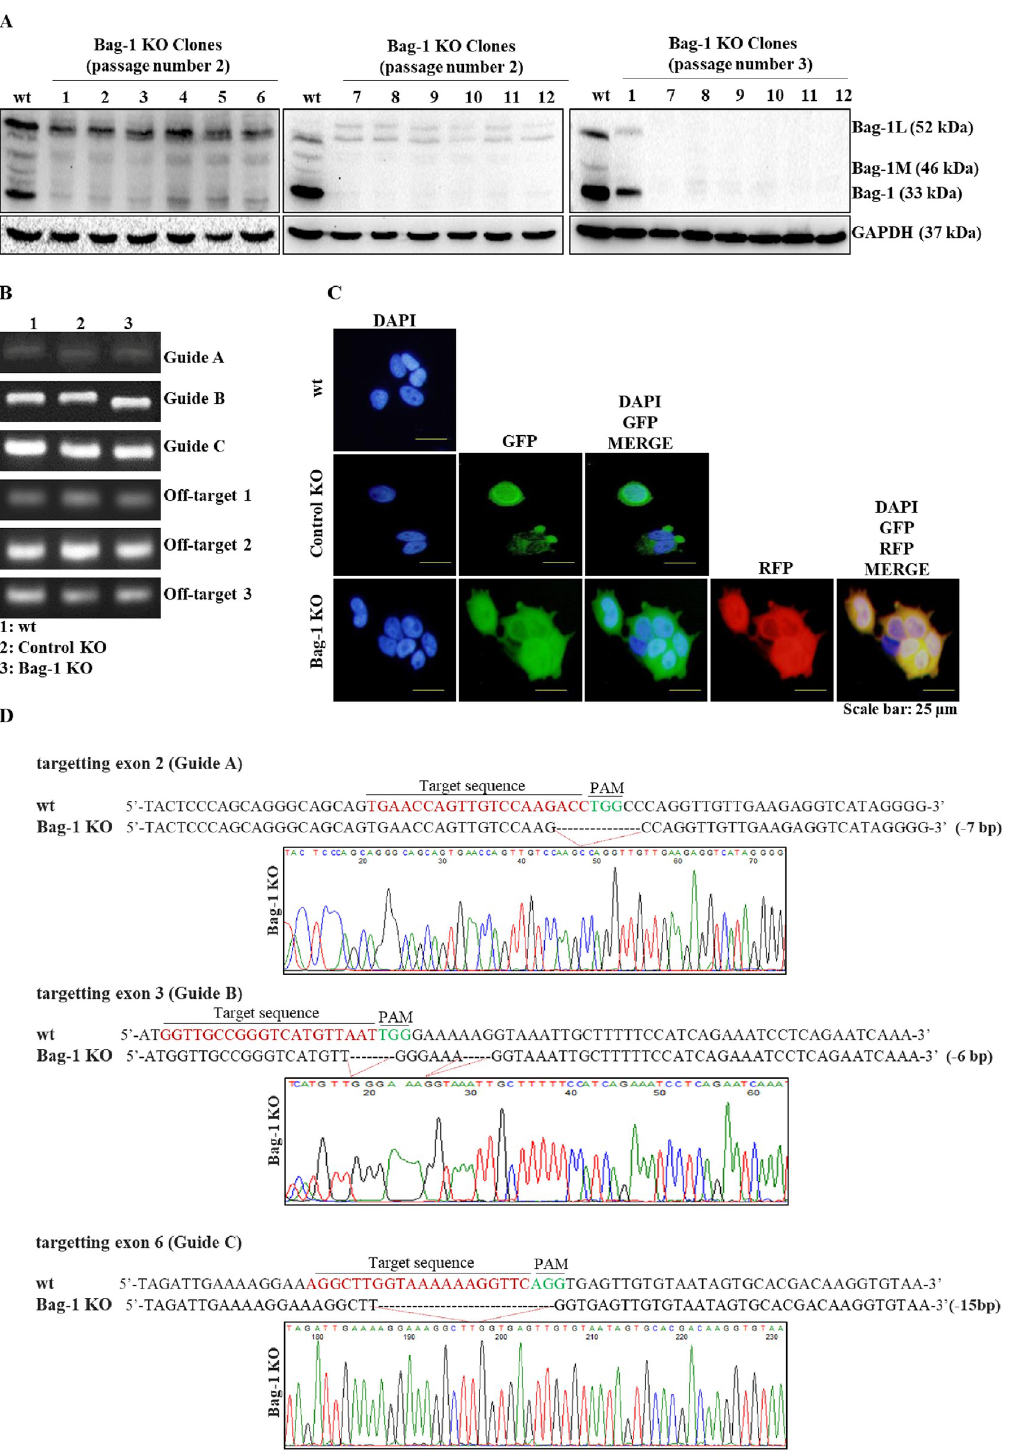
Fig 1. Generation and validation of Bag-1 KO MCF-7 cells. A) Identification of selected clones that exhibit loss of Bag-1 expression by immunoblot analysis of cellular Bag-1 KO cell lysates. GAPDH was used as a loading control. The relative densitometry analysis represented the mean ± SD of three independent experiments. ( �� p = 0.0044, ��� p = 0.0005, ���� p < 00001 by Two-way ANOVA, Tukey’s multiple comparison test, S1E Fig). B) Characterization of base pair differences in selected Bag-1 KO and Control KO cells by genomic PCR analysis. C) Verification of selected Control KO and Bag-1 KO clones by GFP